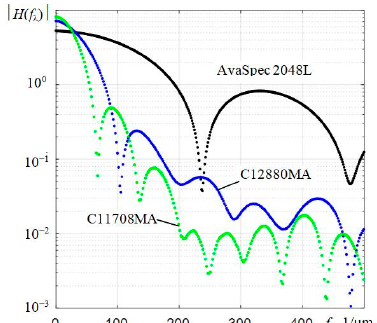
Figure 7. Moduli of the components of the Fourier transforms of the instrumental functions | H ( f λ )| of three types of spectrometers in the frequency f λ range from 0 to 500 1/ μ m. The shape of the ⏐ H ( f λ ) ⏐ modulus for the AvaSpec 2048L spectrometer resembles the spectrum of a rectangular pulse. The first lobe of this modulus ⏐ H ( f λ ) ⏐ has components